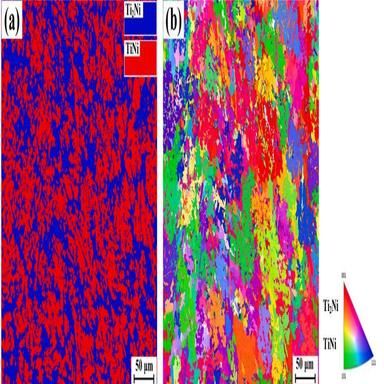
EBSD results of 35% Inconel 625 ratio: (a) EBSD phase distribution map;(b) EBSD orientation map.